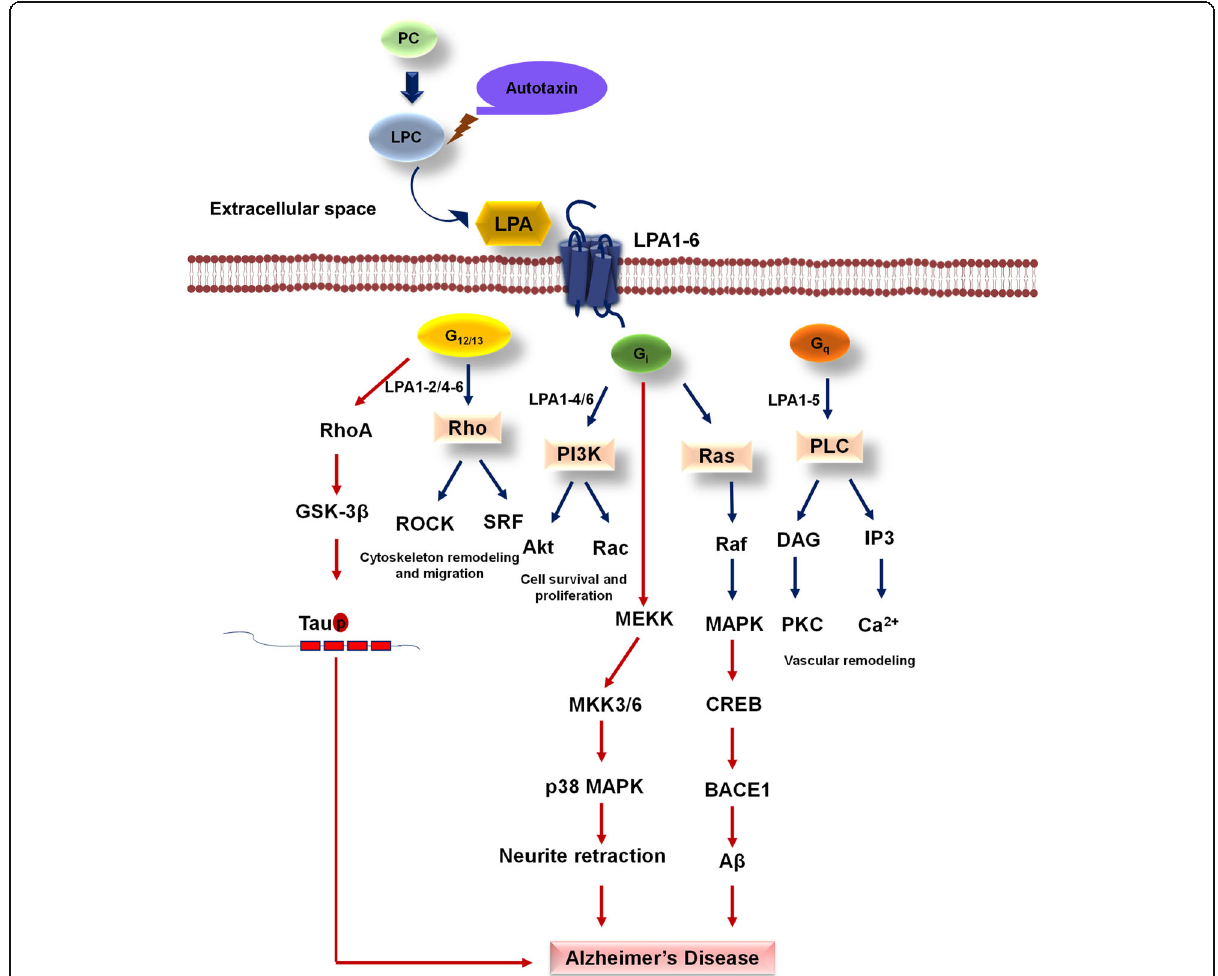
Fig. 5 GPCR in Lysophosphatidic acid cycle. LPA production through LPC via autotaxin enzyme exerts its function through cell surface GPCR mainly G12/13, Gi/o, and G α q protein-mediated signals. Amongst six different LPA, LPA1-2/4-6 exert their function through G α 12/13 and follows Rho-mediated cytoskeleton remodeling which assists cellular migration. LPA1-4/6 exert their function through Gi/o, which is responsible for activating PI3K and Ras-mediated MAPK signaling for cell survival and proliferation. G α q protein-mediated signal activate the PLC pathway results in vascular remodeling on stimulation by LPA1-5. Defect in signaling through G α 12/13 in AD abnormally increases active GSK-3 β , which increases phospho-Tau. Gi leads to dysregulation of BACE1, which impose abnormal A β and neurite retraction via p38 MAPK